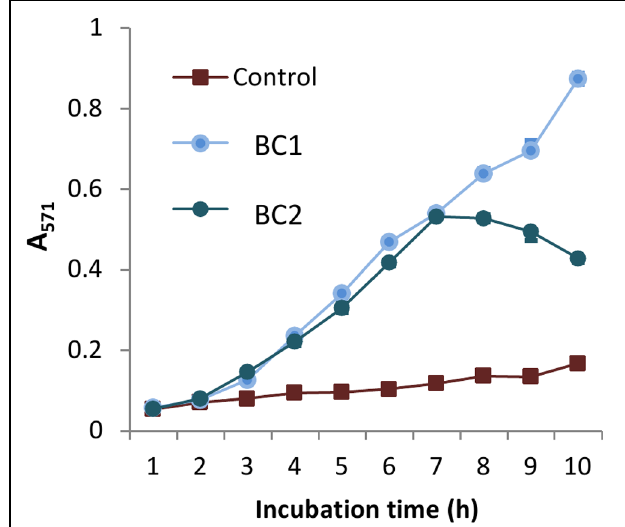
FIGURE 7 | B. cereus produces reactive oxidizing species under microaerobic conditions. BC1 and BC2 microaerobic cultures were grown in DMEM with 1 g L − 1 of BSA, 0.1 mM of AR reagent, and 0.2 U L − 1 of HRP using 24-well plates (1 mL per well). Sups were collected every hour and their absorbance was read in triplicates, via spectrophotometer at 571 nm. The reaction mixture including all components except the bacterial inoculum was used as a